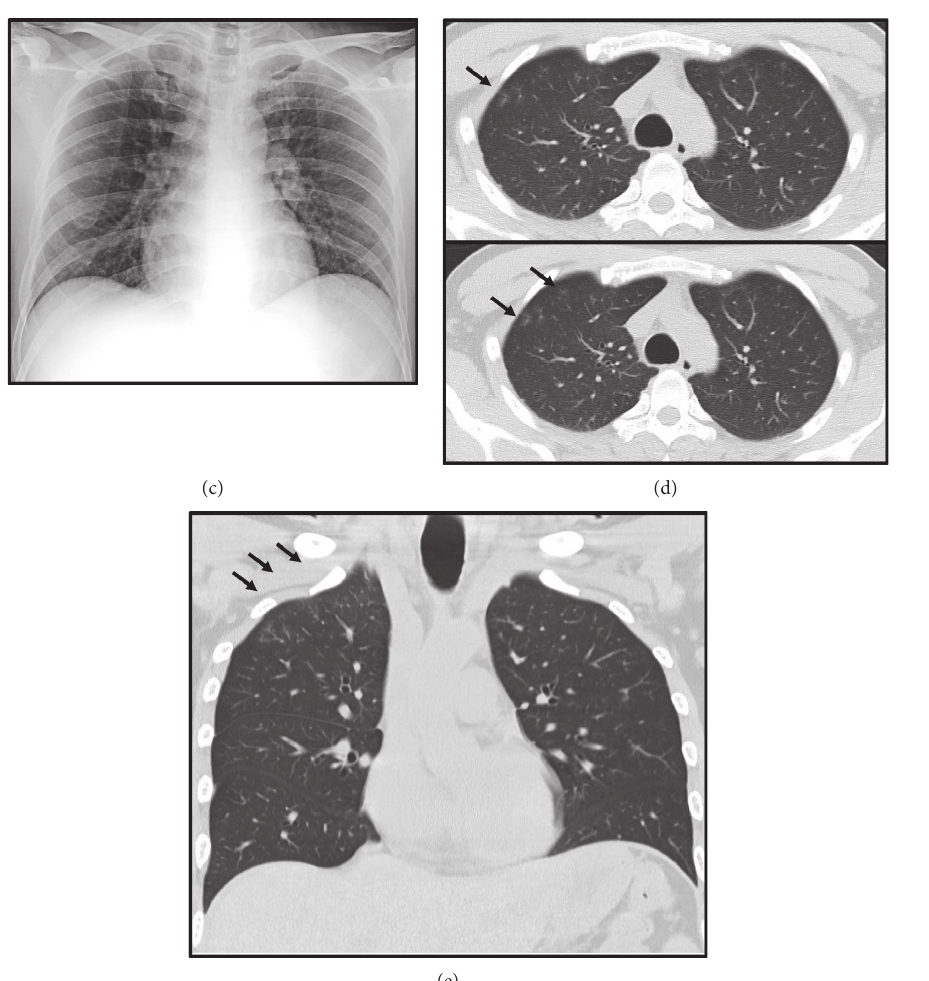
Figure 3: Images in a 35-year-old male with acute myeloid leukemia who had positive chest symptoms and serum galactomannan test. (A) Baseline chest film shows opacities at right upper and right lower lungs. (B) Chest film on second day of febrile neutropenia (ANC � 0 μ L) shows improvement of previous opacities with no new opacity. (C) Chest film on fifth day of febrile neutropenia (ANC � 0 μ L) shows no abnormal opacity. (D–E) Axial and coronal CT chest on seventh day of febrile neutropenia (ANC � 0 μ L) reveals subtle ground-glass attenuation at right upper lobe (arrows). This case was evaluated as false-negative chest radiograph and true-positive CT chest.